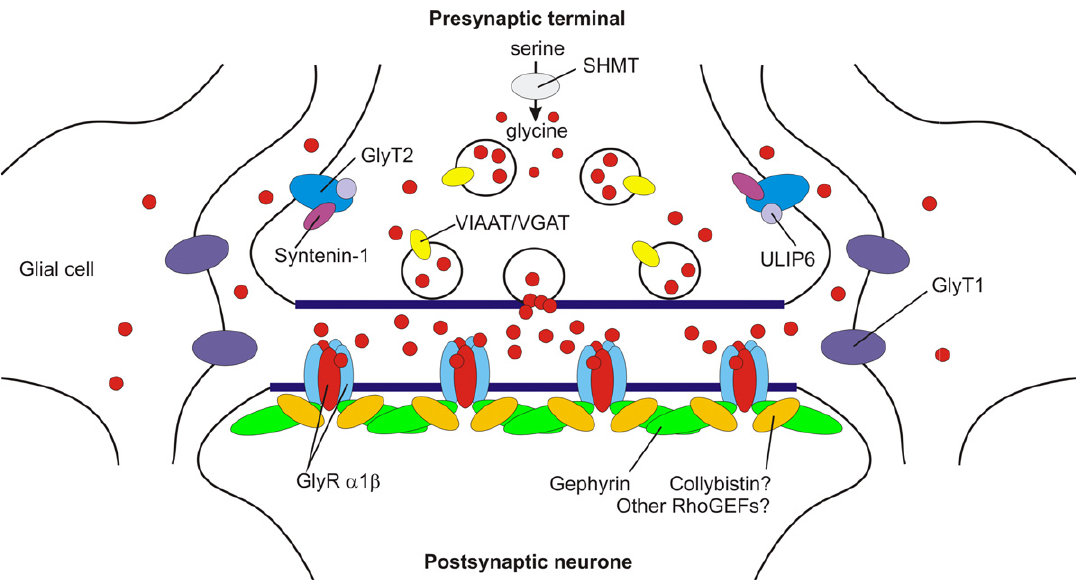
Figure 1. A model showing key proteins at mature glycinergic synapses. Postsynaptic α 1 β subunit GlyRs are clustered by gephyrin. Although the RhoGEF collybistin is responsible for the translocation of gephyrin to GABAergic synapses (Harvey et al., 2004; Papadopoulos et al., 2007), collybistin may be dispensa- ble for GlyR clustering, since collybistin knockout mice do not exhibit developmental onset of exaggerated acoustic or tactile startle responses (Papadopoulos et al., 2007). This suggests that additional RhoGEFs involved in the synaptic localisation of gephyrin and inhibitory receptors remain to be identifi ed. The glial glycine transporter GlyT1 removes glycine from the synaptic cleft, thereby terminating neurotransmission. By contrast, GlyT2 (which binds ULIP6 and syntenin-1) is responsible for glycine re-uptake into the nerve terminal cytosol. This in turn provides glycine for the vesicular transporter VIAAT to refi ll synaptic vesicles. Glycine is also synthesised by a de novo pathway involving serine hydroxymethyl transferase (SHMT). Loss of glial GlyT1 uptake may cause raised CSF and serum glycine, leading to glycine